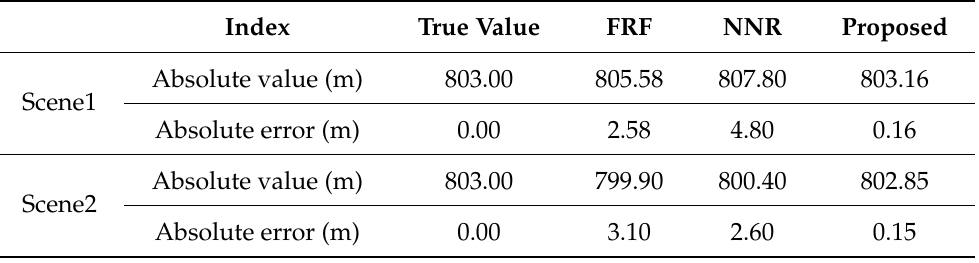
Table 2. Reconstruction performance of the back of building 1 in simulation